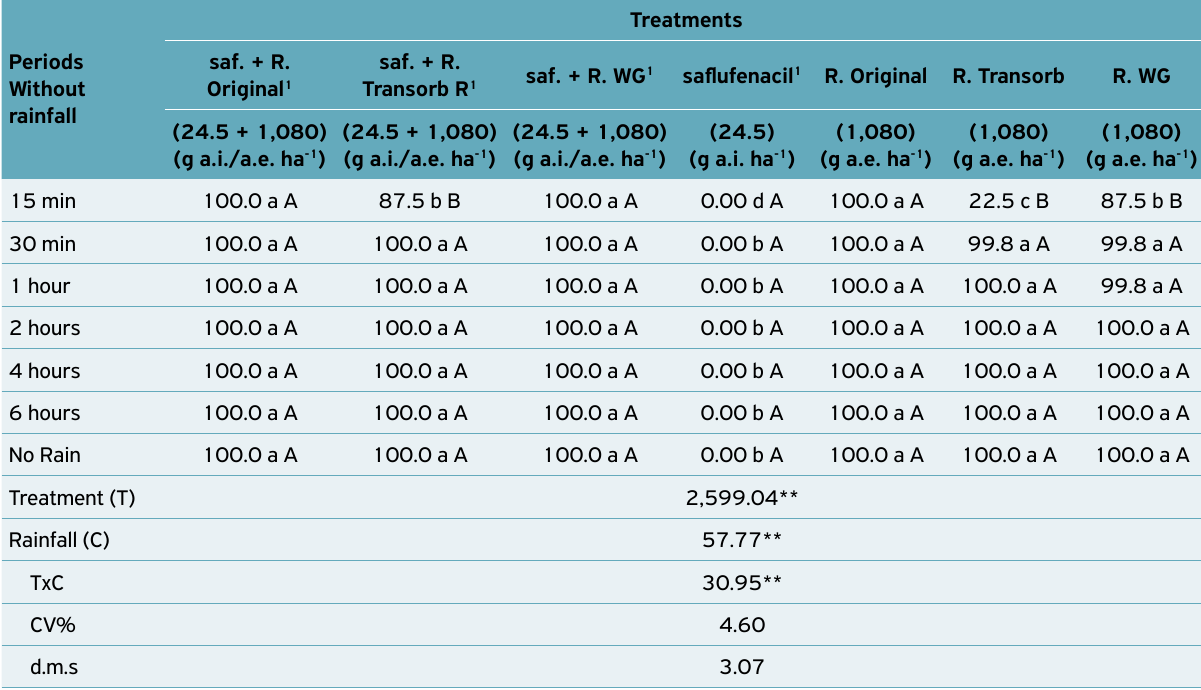
Table 5. Mean values for percentage of control of Brachiaria decumbens at 28 DAA obtained by the unfolding of degrees of freedom of the interaction between herbicides and periods without rain after the application of